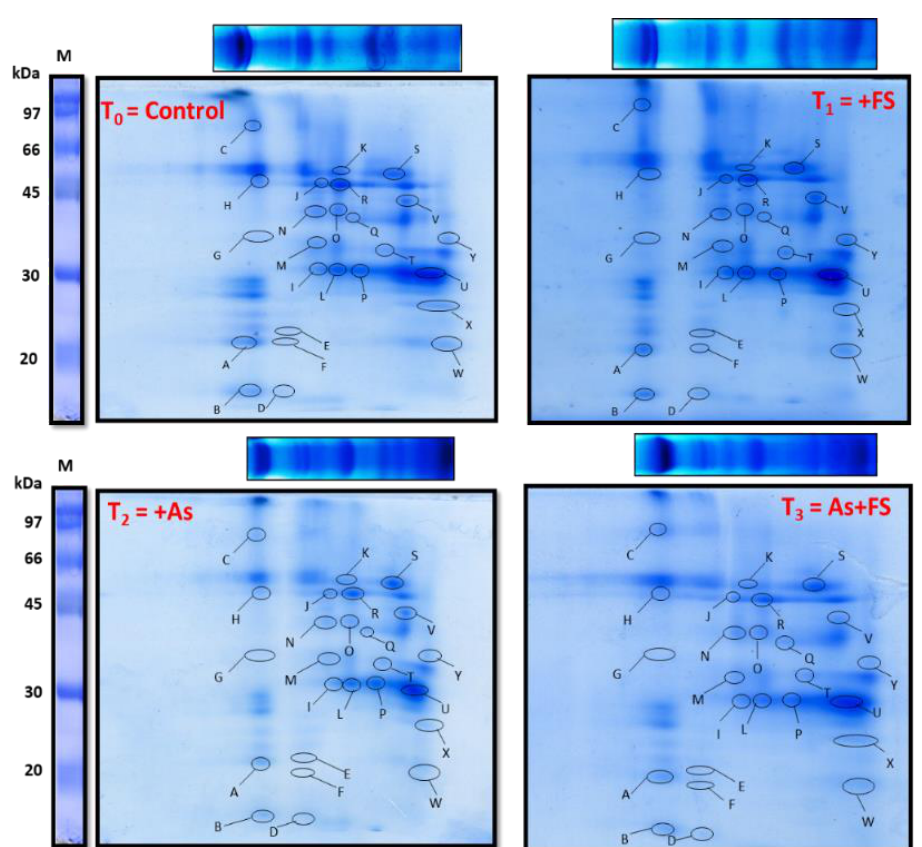
Figure 11. SDS-PAGE (2nd dimension) gels of thylakoid membrane proteins of Brassica juncea in four treatment sets T 0 (control), T 1 (+FeSO 4 ), T 2 (+As), T 3 (As+FeSO 4 ) at 14 DAT obtained by layering BN-PAGE gel lanes on a 15% acrylamide gel. Proteins differentially expressed and identified by MALDI-TOF mass spectrometry were marked with letters A to Y in each gel. As, Arsenic; FS, FeSO 4 . Of the 25 differentially expressed spots, spot ID A (Photosystem I subunit F), B (Photosystem II reaction center protein L) and M (Photosystem II protein D1), representing subunits of both complexes PSI and PSII, were found to be downregulated both during +As and (As+FeSO 4 ) treatments, more strongly in the +As set. These were